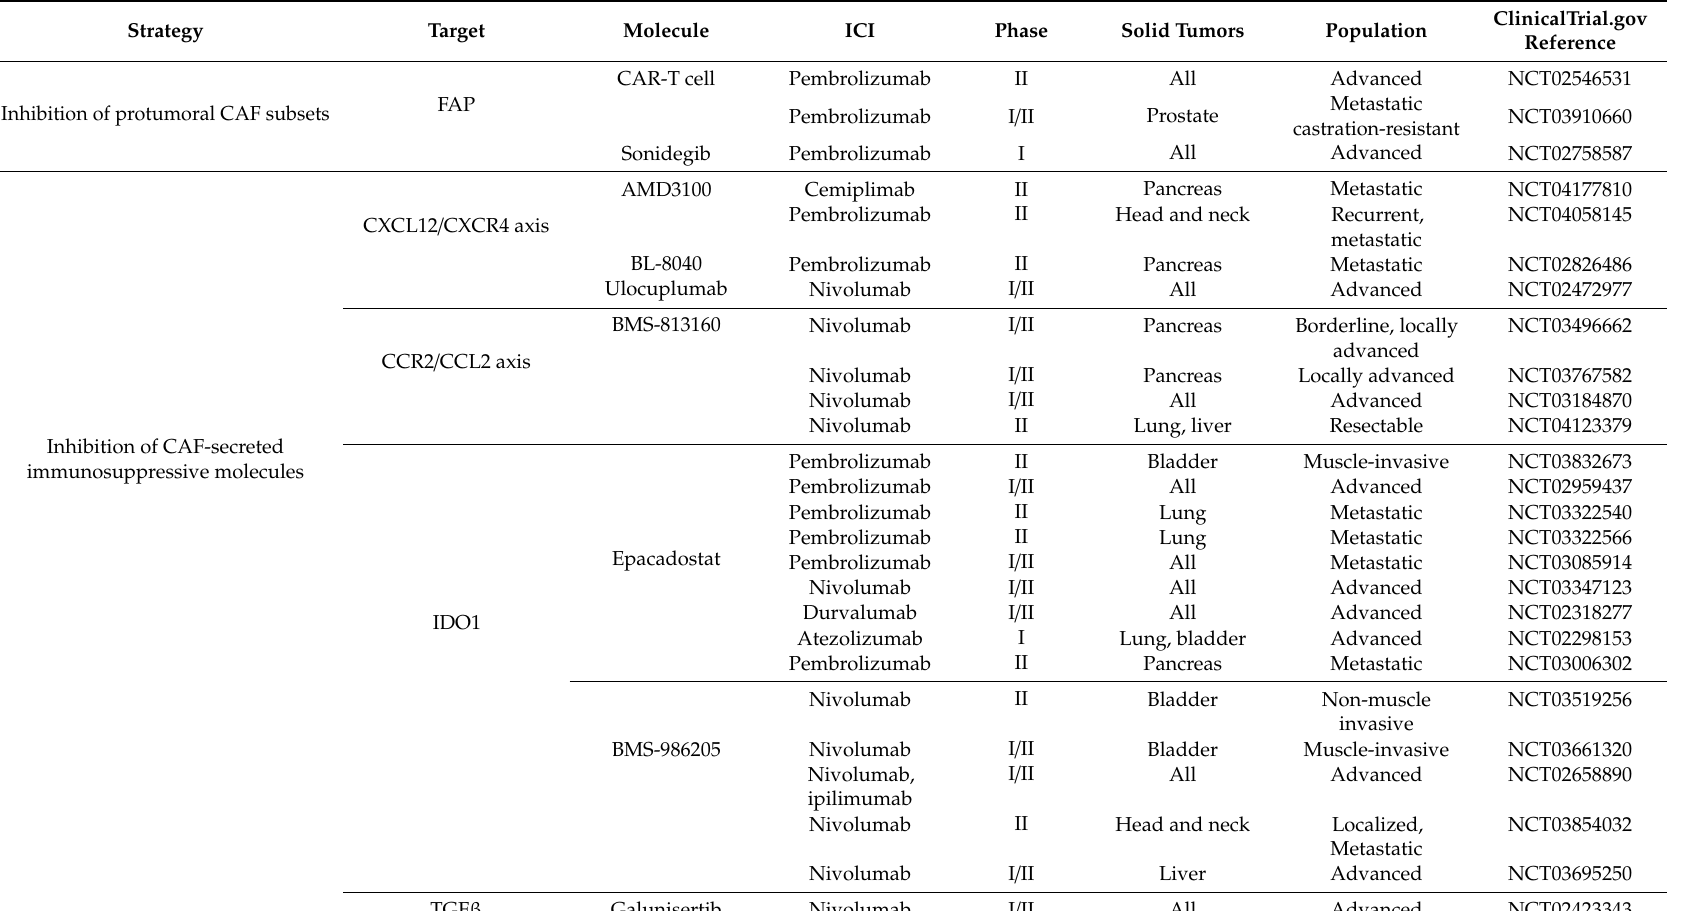
Table 3. Ongoing clinical trials evaluating modulation of cancer-associated fibroblasts in combination with ICI in solid tumors 1